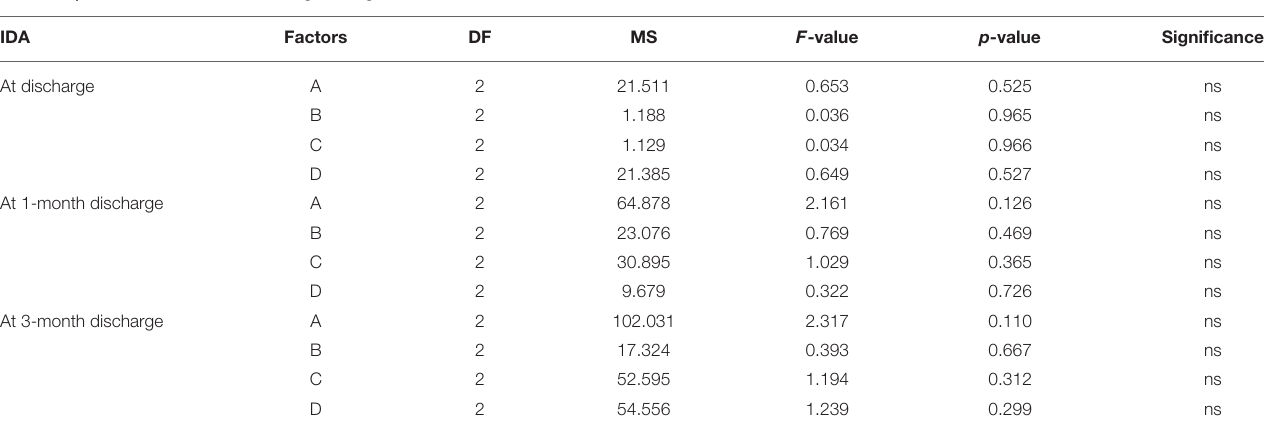
TABLE 8 | ANOVA of the factors affecting the negative emotions.